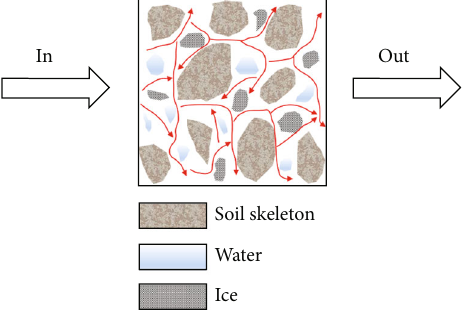
Figure 8: Detailed volume-weighted average REV model.